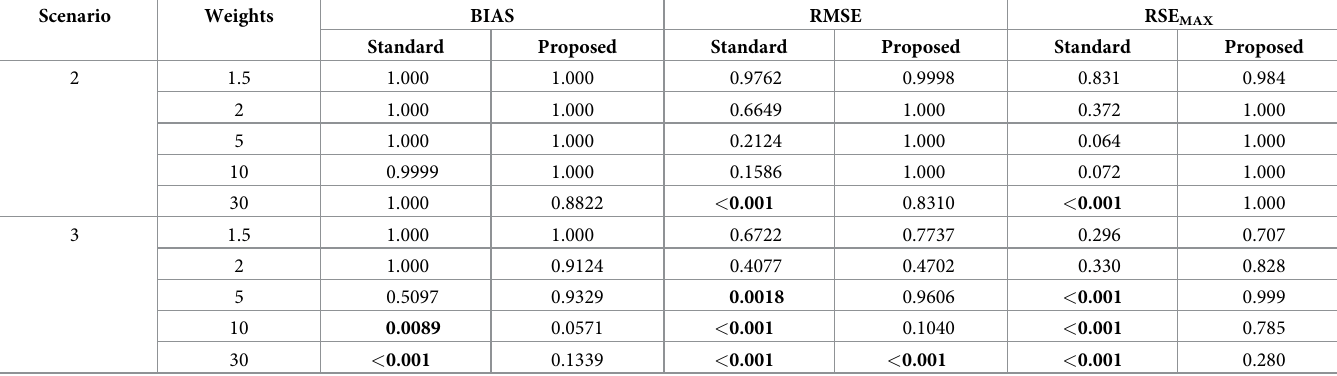
Table 9. Dunnett’s test p-values comparing each simulated configuration with the reference simulation (Rasch model with scenario 1). Scenario